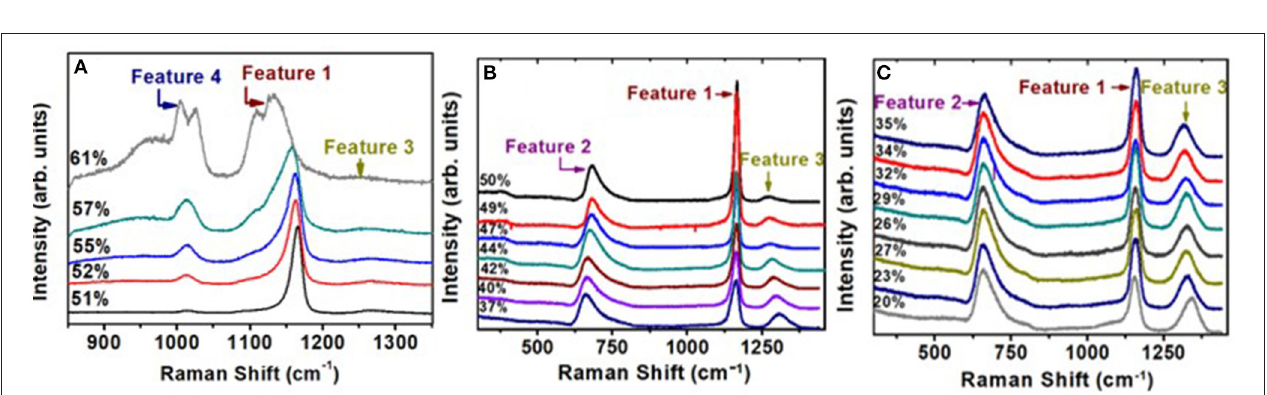
FIGURE 7 | (A) Variations in the Raman P–O t symmetric stretch mode frequency and linewidth (FWHM) as a function of glass composition. (B) Raman polarization results on g-NaPO 3 showing both the I VV and I VH scattering of Q 2 species. Note that in the I VH scattering, one observes two satellite modes on the low-frequency wing near 1,151 cm − 1 and near 1,105 cm − 1 of the majority mode near 1,166 cm − 1 . The scattering strengths of the triad of modes associated with the Q 2 species vary with x in a rather systematic fashion ( Figure 10 ).